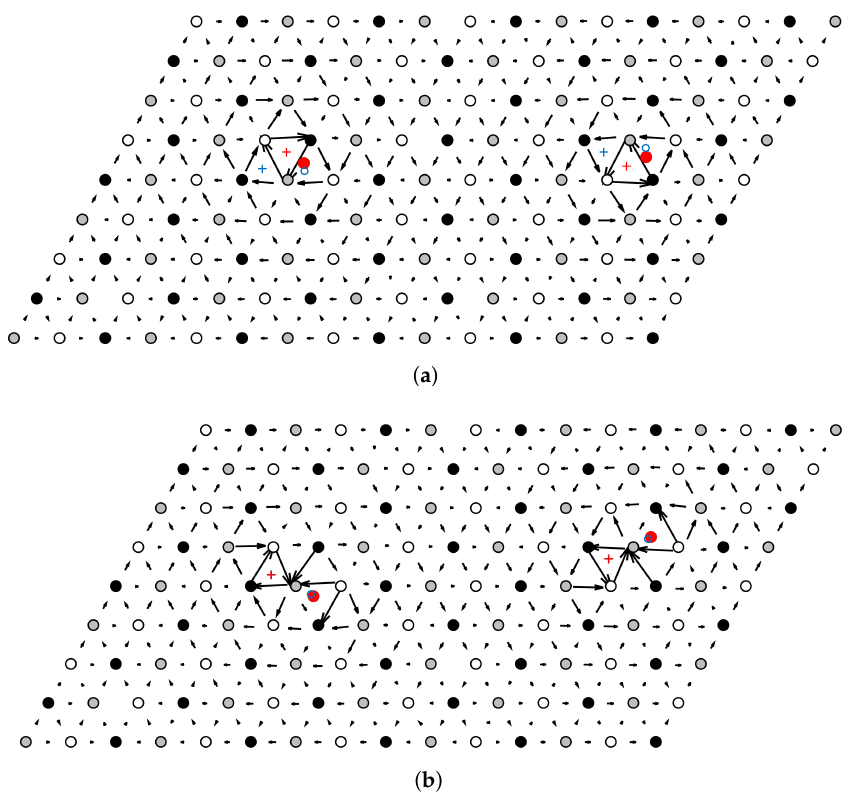
Figure 8. Stable relaxed configurations of the dislocation core/O-atom system. All other initial configurations (see Figure 2) relax to one of these. The cross marks the location of the dislocation core (blue: initial, red: final), while the blue and red dots mark the initial and final position of the O atoms, respectively. ( a ) The initial configuration starts with the oxygen atom in a fourth NN tetrahedral position. After relaxation, the core shifts to a hard core configuration, and the oxygen atoms shifts to a second NN position. The dislocation maintains its compact core structure after